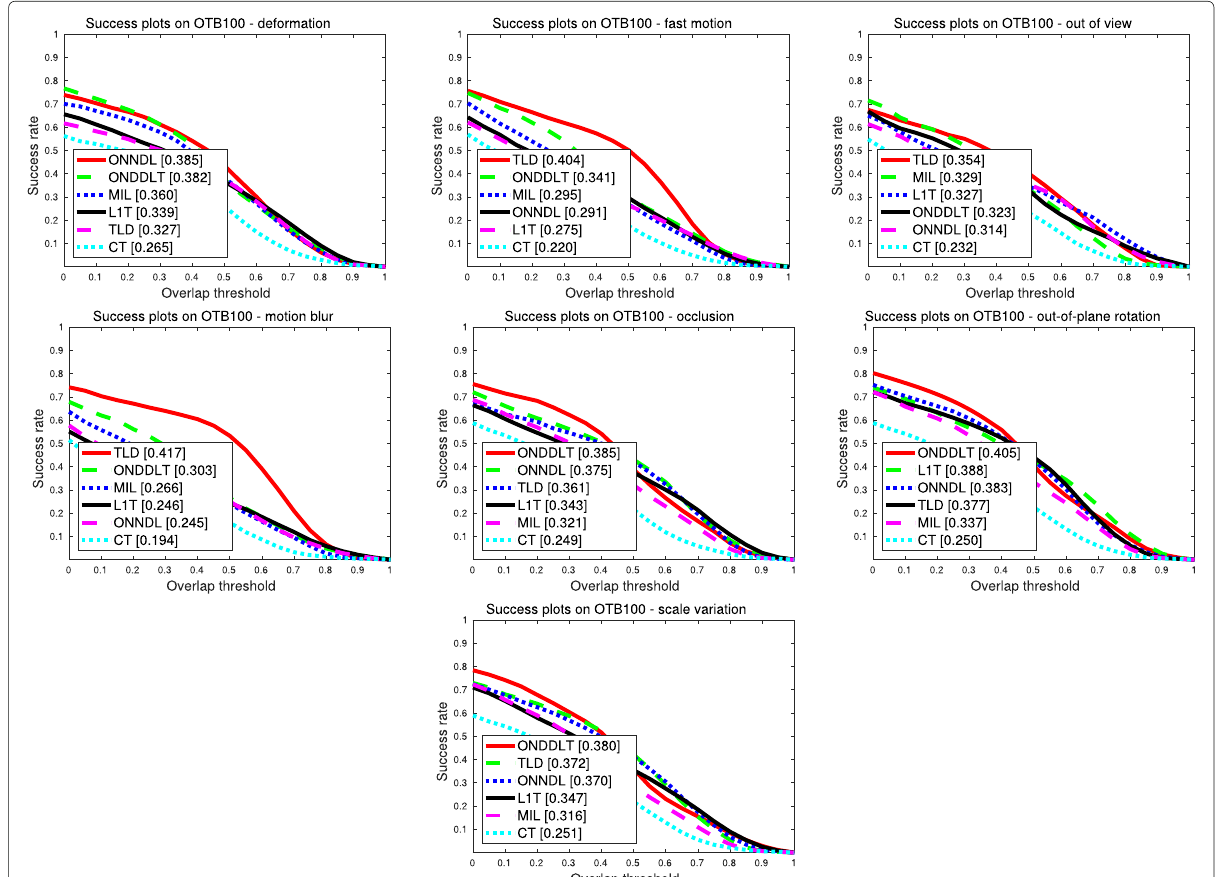
Fig. 5 Success plots of DEF, FM, OV, MB, OCC, OPR, and SV attributes on the OTB100